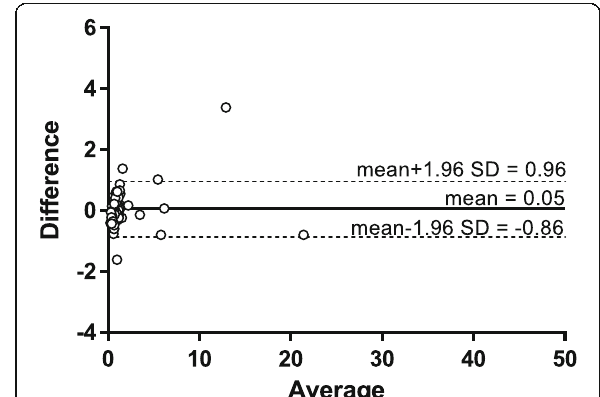
Fig. 5 Bland-Altman plot of the difference between the new method and Chromsytems vs. the average of the two methods. The continuous line represents the mean of the differences between the two methods while the dotted lines represent the limits of agreement from − 1.96 SD to + 1.96